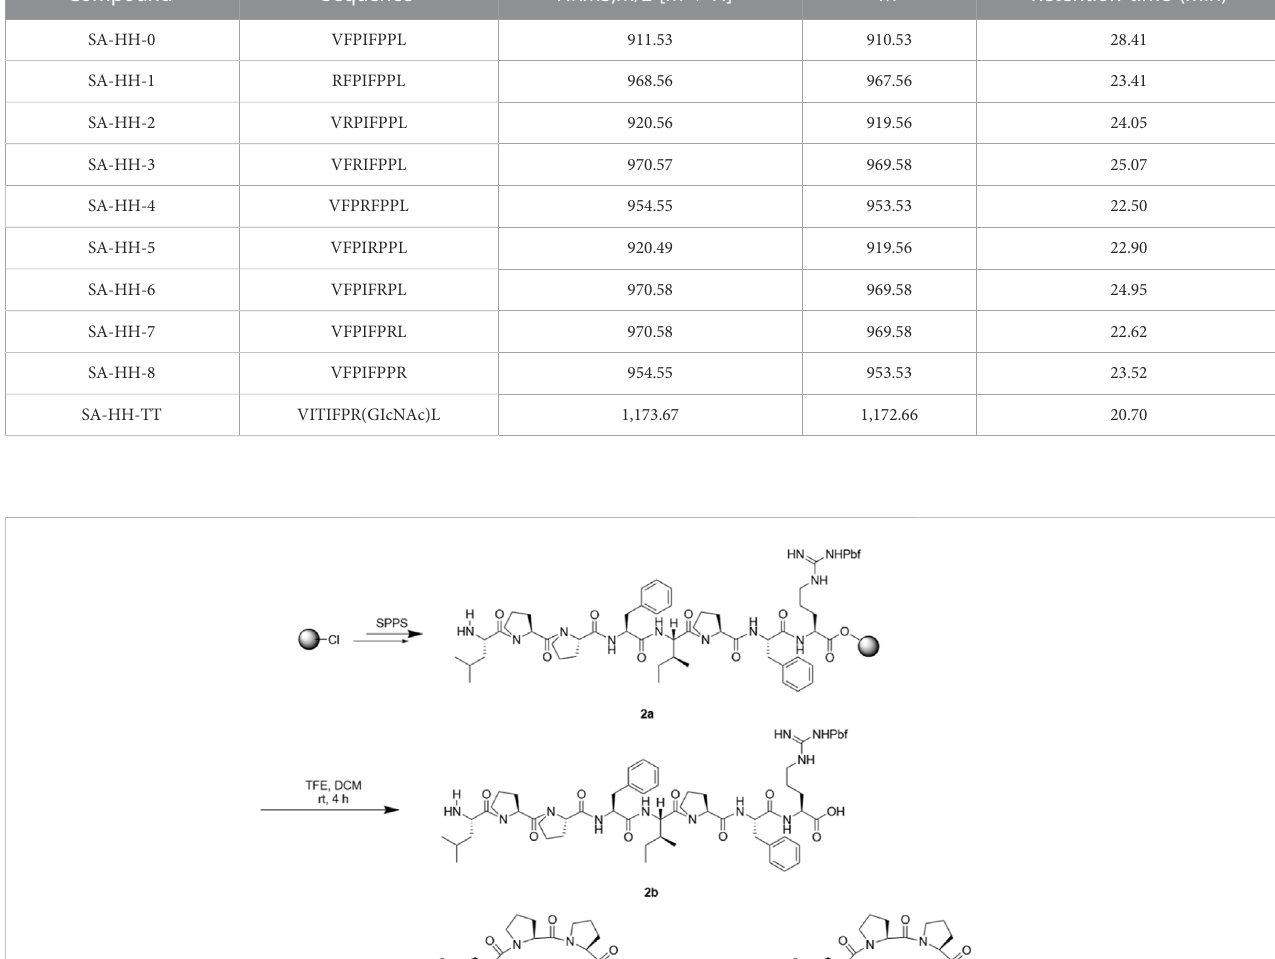
TABLE 1 Detailed data of Samoamide A derivatives. Compound